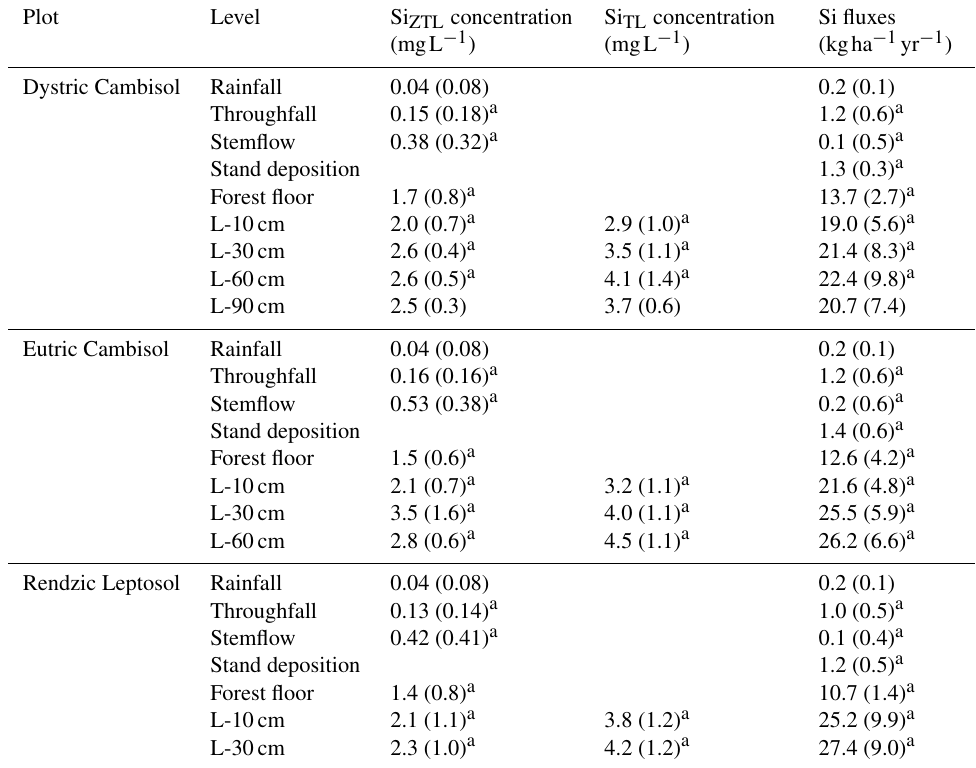
Table 4. Si content and fluxes in the ZTL (zero-tension lysimeter) and TL (tension lysimeter) solutions of the three soils at the Montiers site. SD values are given in brackets. Values with different letters are significantly different according to a Kruskal–Wallis test at the threshold P value level of 0.05 (soil effect; DC, EC and